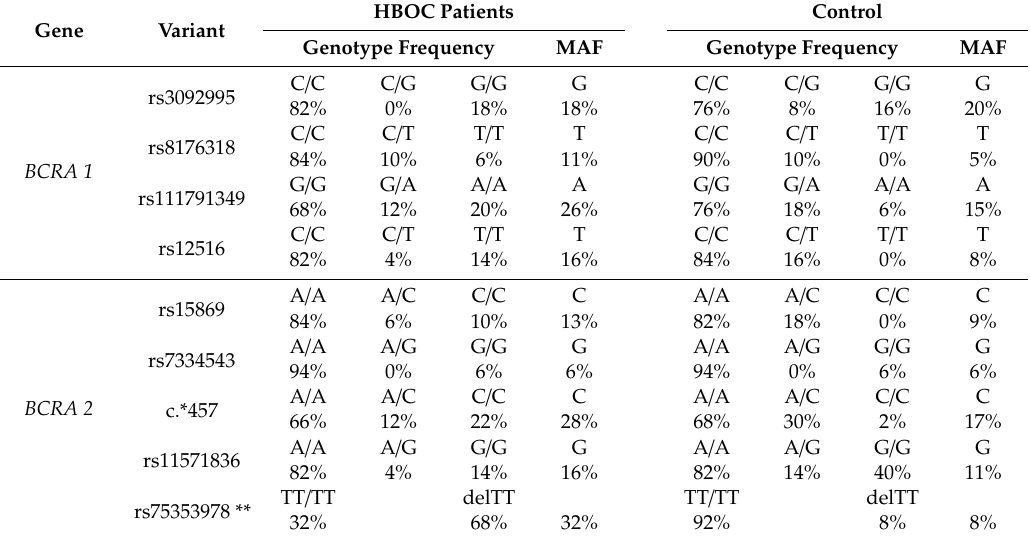
Table 3. Comparison of the genotypic and allelic frequencies of variants between the HBOC and control groups by